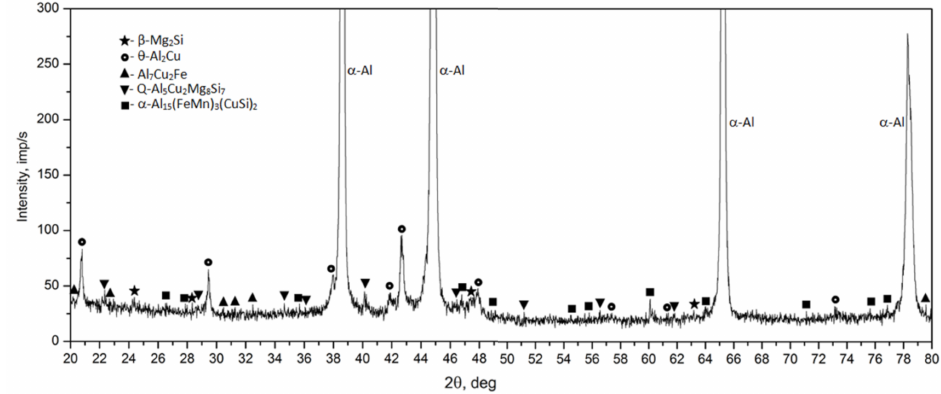
Figure 8. X-ray diffraction pattern of the 2017A alloy after